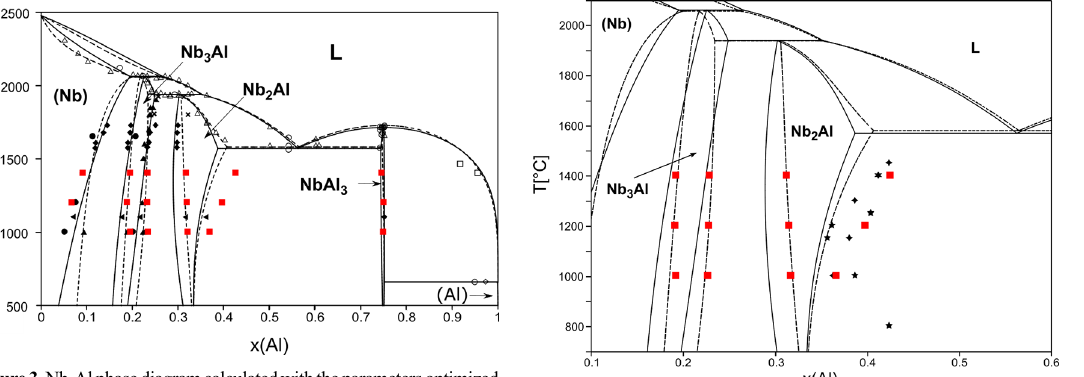
Figure 3. Nb-Al phase diagram calculated with the parameters optimized by Witusiewicz et al. 7 (solid lines) and He et al. 8 (dashed lines) along Figure 4. Details of Nb-Al phase diagram calculated with the with experimental data from: This work ( EPMA), Jorda et al. 20 ( parameters optimized by Witusiewicz et al. 7 (solid lines) and ▲ XRD; ∆ DTA/LTA; × EPMA), Kokot et al. 21 (◄ XRD), Menon He et al. 8 (dashed lines) along with experimental data from: et al. 22 (● EPMA), Shilo et al. 23 ( ♦ Knudsen Effusion), Witusiewicz This work (■ EPMA), ternary Co-Nb-Al ★ 11 and Fe-Nb-Al ✦ et al. 7 (○ DTA), Wicker et al. 18 (□ DTA) and Zhu et al. 24 (◊ DSC). 9, 10 alloys. ✸ Note: (Nb) phase’s composition measurement in Nb12Al alloy equilibrated at 1000 °C was removed from the figure because of its low reliability. Figure 4 show details of the Nb-Al phase diagram in the Nb Al region along with the EPMA composition measurements 2 for this phase. The square symbols are from the present work while the stars are from measurements in ternary samples (Al-Co-Nb 11 or Al-Fe-Nb 9,10 ) positioned in three phase field equilibria in which the third component (Co or Fe) solubility is lower than 1 at.% in the Nb Al phase. Our results are in 2 agreement with the results from Silva 10 (alloy heat treated at 1400 °C/75h) and Stein et al. 9 (alloys heat treated at 1450 °C/50 h, 1150 °C /168 h and 1000 °C/1000 h). However, the alloy heat treated at 1300 °C/100 h in the work of Stein et al. 9 presented a slightly lower Al solubility. Compared with the results from Dovbenko et al. 11 , our results are in agreement with the measurement obtained from the alloy heat treated at 1250 °C/72 h. However, the results at 1200 °C/96 h and 1150 °C/136 h presented significantly lower Al contents while for the samples 1000 °C/236 h and 800 °C/1000 h the contents were higher than the